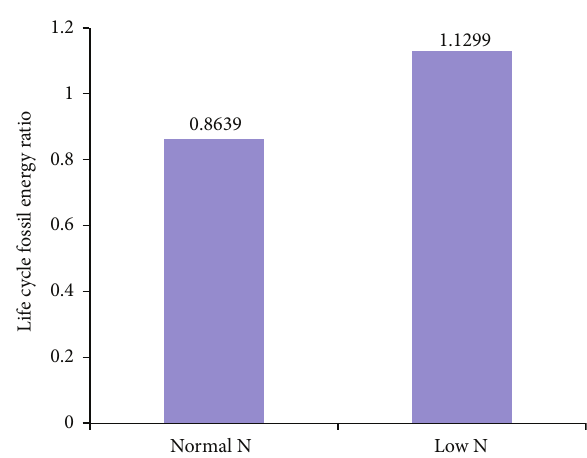
Figure7:Lifecyclefossilenergyratiofortheproductionofbiodiesel from algal oil extracted from dried and wet